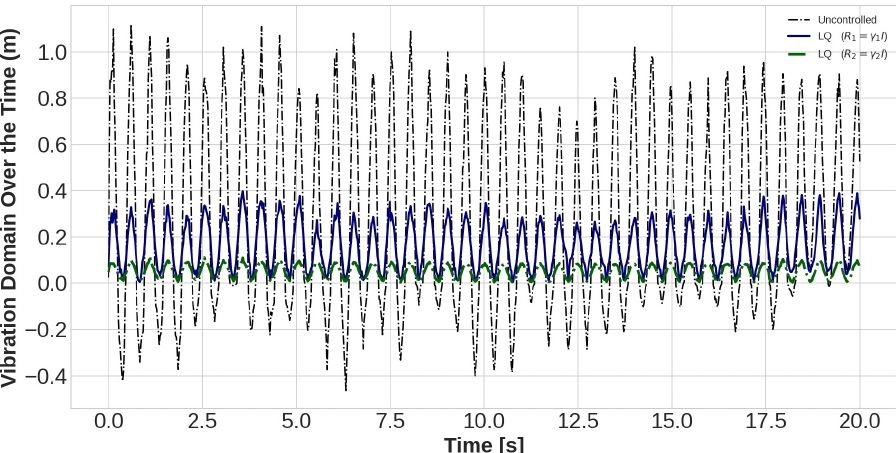
Figure 15. The lateral vibration domain with 2 different Gamma amounts ( γ 1 = 10 − 11 and γ 2 = 10 − 13 ) for the forty-fifth sensor under loading number 2 (30-degree attack